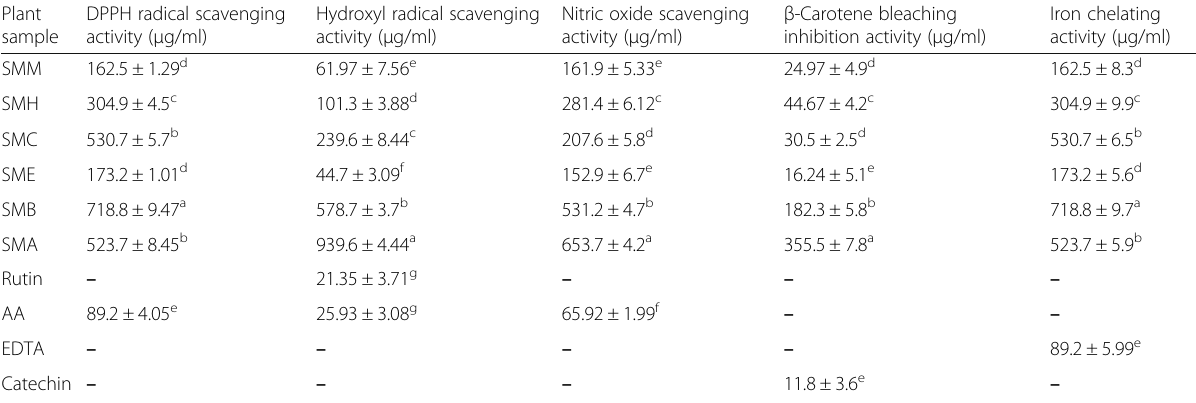
Table 2 IC 50 values ( μ g/ml) of different antioxidant activities of S. mukorossi Plant